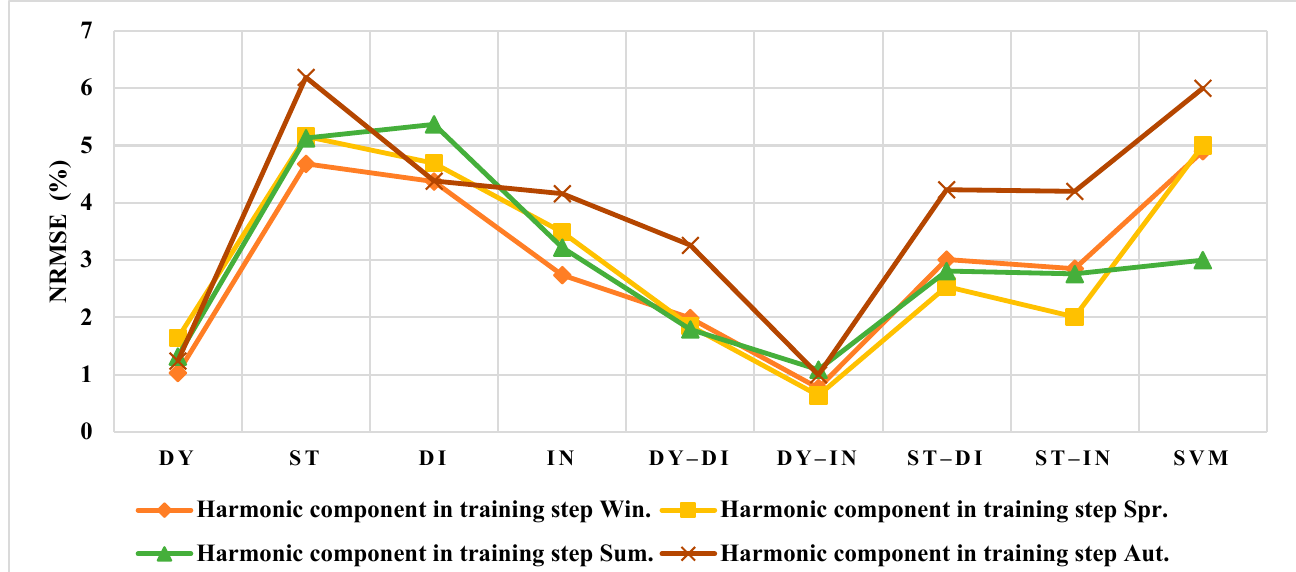
Harmonic component in training step Win. Harmonic component in training step Spr. Harmonic component in training step Sum. Harmonic component in training step Aut.